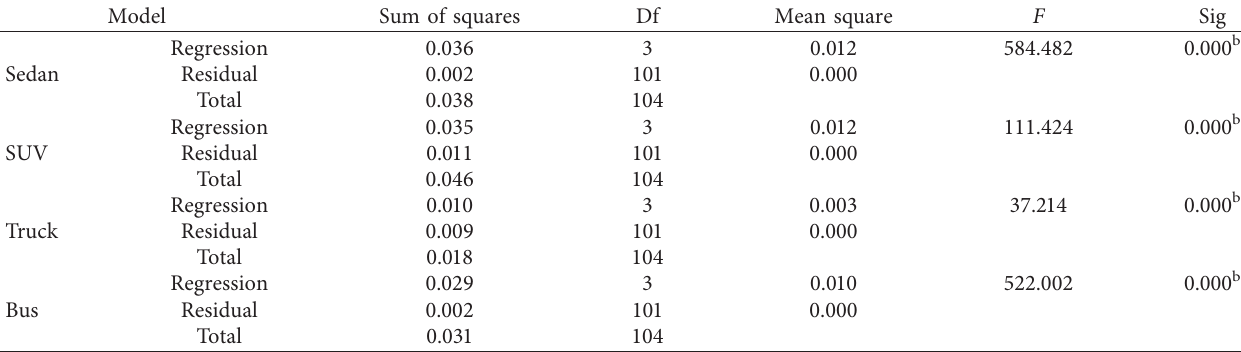
Table 3: ANOVA test results for vehicle’s lateral friction